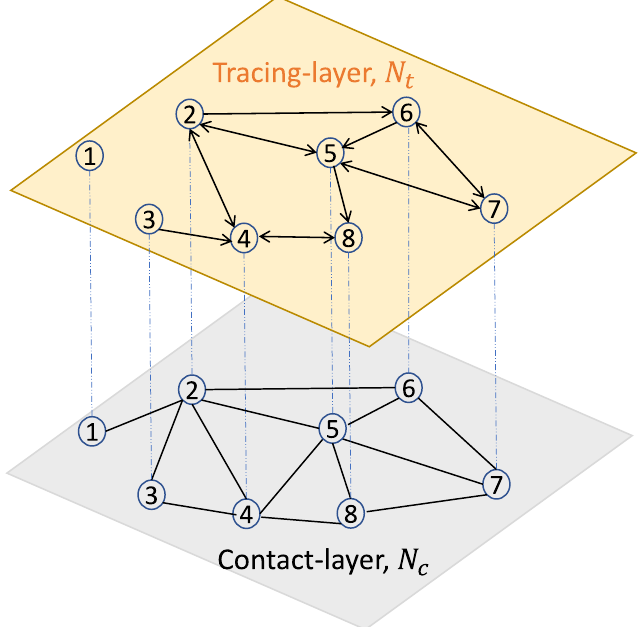
Figure 5. Two-layer network model: contact-layer N C , and tracing-layer N t . In this example, 50% of contacts of each node is traced. For example, node 4 has four neighbors in the contact-layer (2, 3, 5, 8); however, two neighbors in the tracing-layer (2, 8). Node 7 has three neighbors in the contact-layer (6, 5, 8); however, two neighbors in the tracing-layer (6, 5). Node 8 has three neighbors in the contact-layer (4, 5, 7); however, one neighbor in the tracing-layer